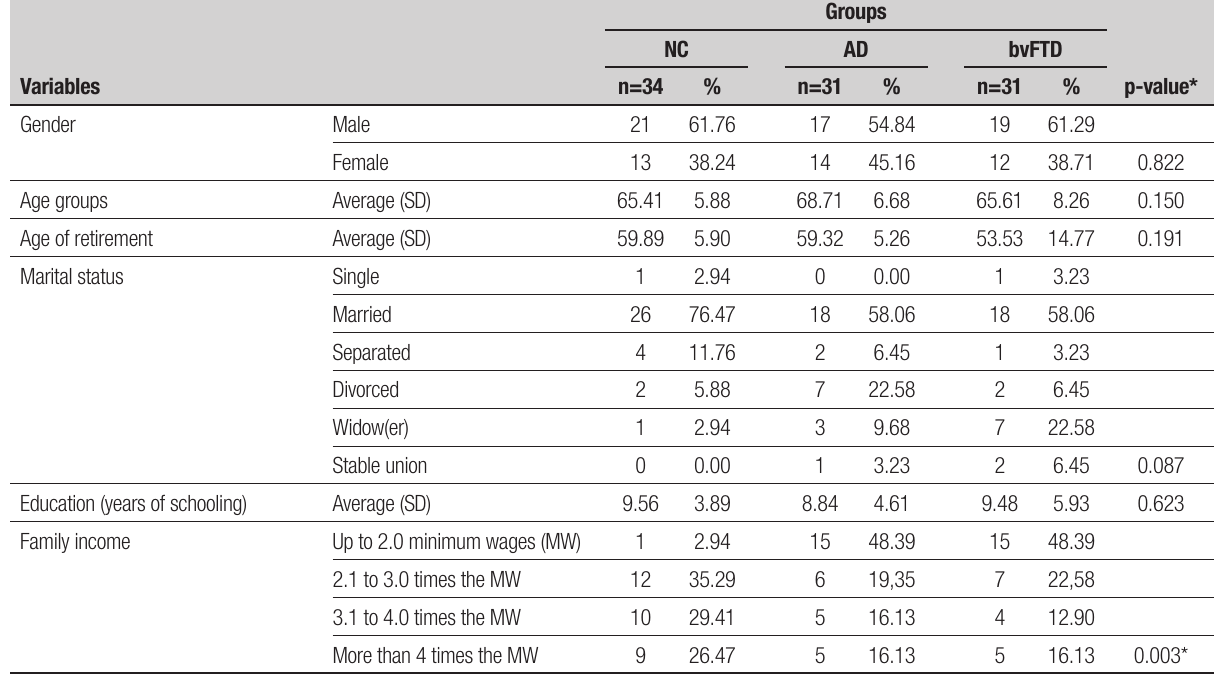
Table 1. Sociodemographic profile of participants, stratified by diagnostic group.